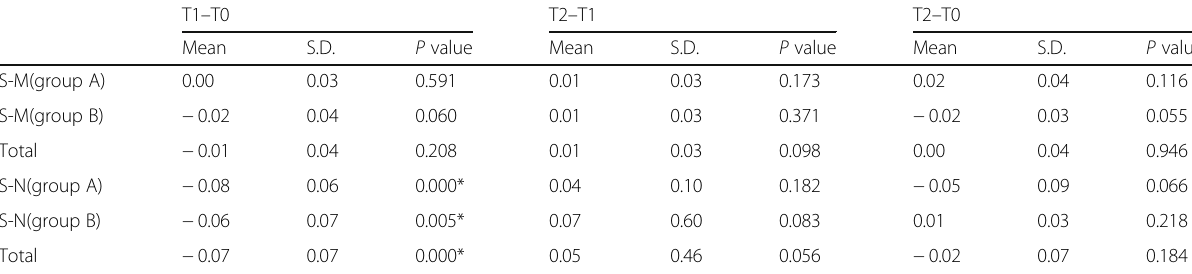
Table 4 Positional changes of the condyle on the sagittal view